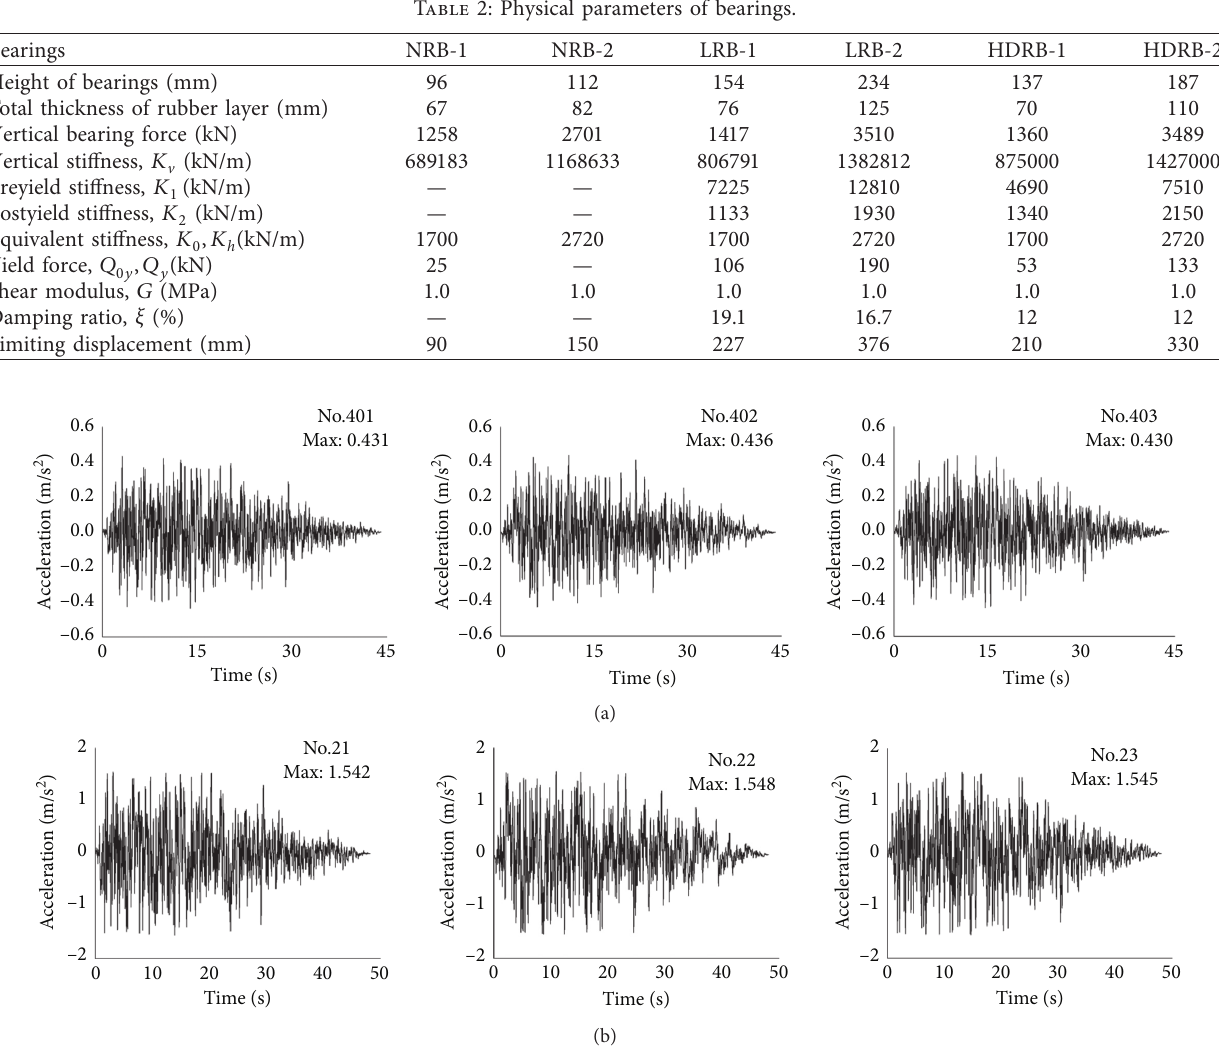
Figure 6: Time history and acceleration response spectrum of the earthquakes: (a) time history of the small earthquakes; (b) time history of the large